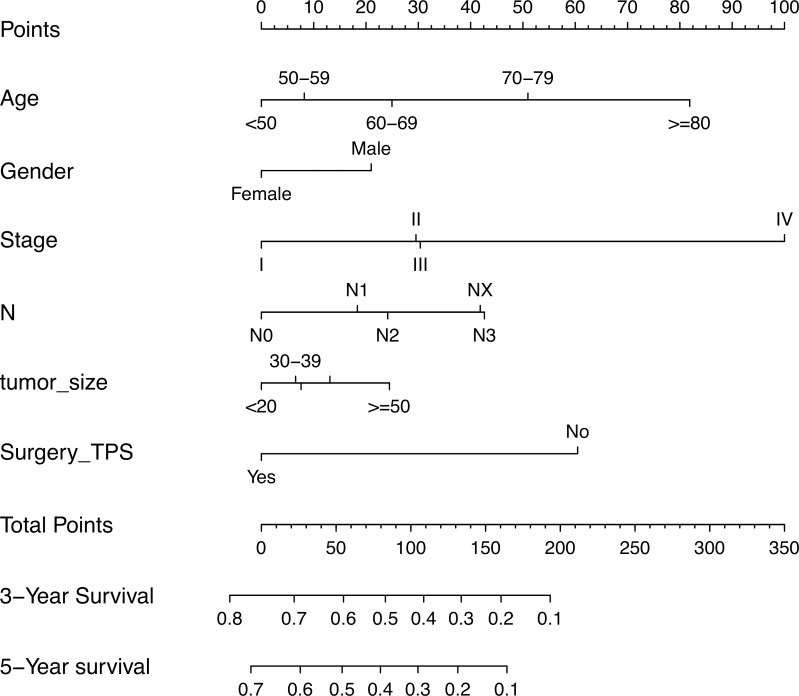
Nomogram predicting 3- and 5-year OS of patients with LCNEC.The nomogram summed the points identified on the scale for each variable. The total points projected on the button scale indicate the probabilities of 3- and 5-year OS.